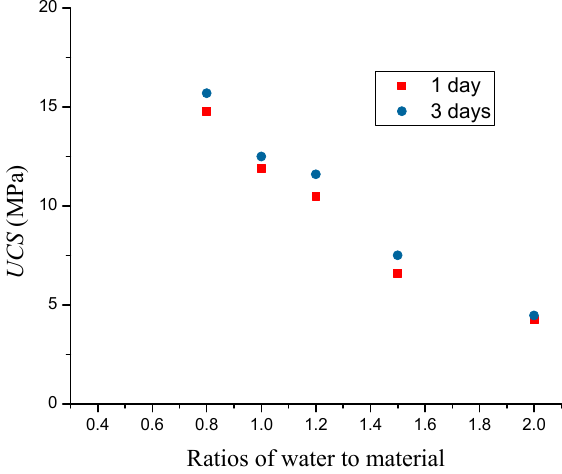
Figure 8. UCS of grouting materials under different ratios of water to material.